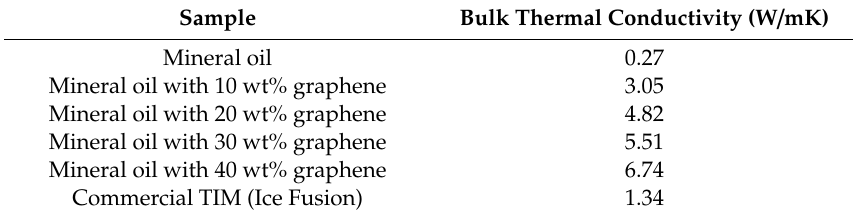
Table 1. Thermal conductivity of graphene-enhanced thermal interface materials